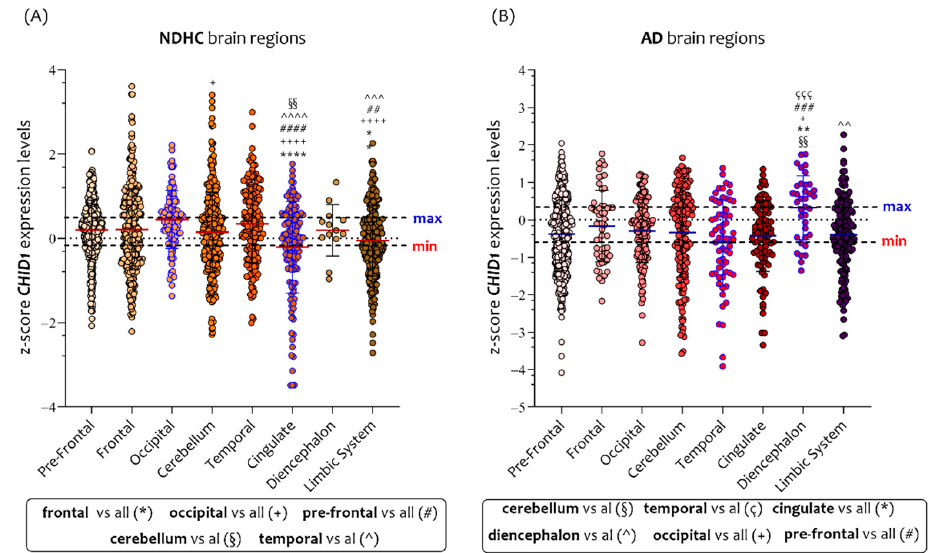
Figure 6. CHID1 levels are differentially expressed in brain regions of NDHC subjects and AD patients. Analyzing the NDHC individual brain regions, we observed that the highest CHID1 expression levels were in the occipital cortex, while the lowest in the region of cingulate ( A ). As regards the AD patients’ brain regions, we observed that the highest CHID1 expression levels were in the diencephalon, while the lowest at the region of the temporal cortex ( B ). See the text for details. Data in the figure are indicated as z-score intensity expression levels and presented graphically as violin dot plots. p values < 0.05 were considered to be statistically significant (ns = not significant; +, * p < 0.01; §§, ##, ^^, **, p < 0.001; ^^^, ççç, ###, p < 0.0001; ++++, ####, ^^^^, ****, p < 0.00001).